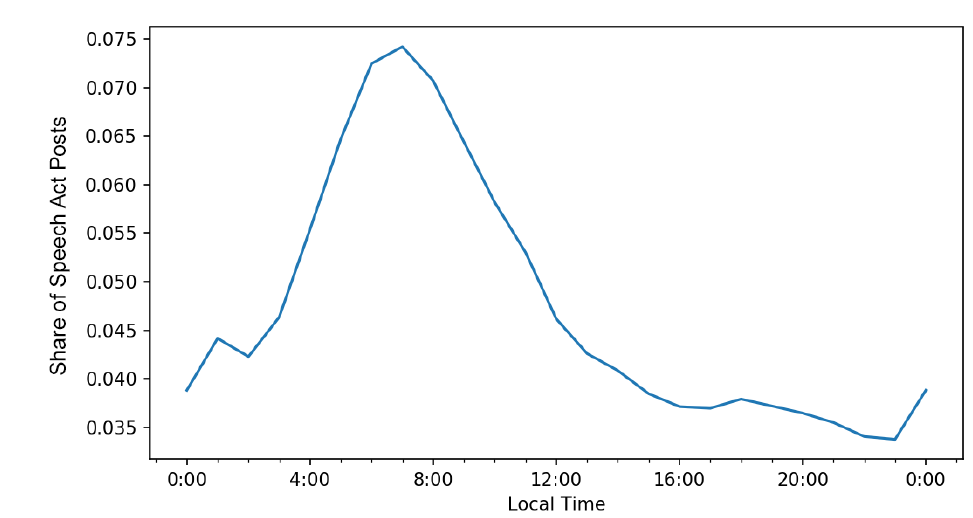
Figure 5. Daily patterns of greetings and speech acts in local